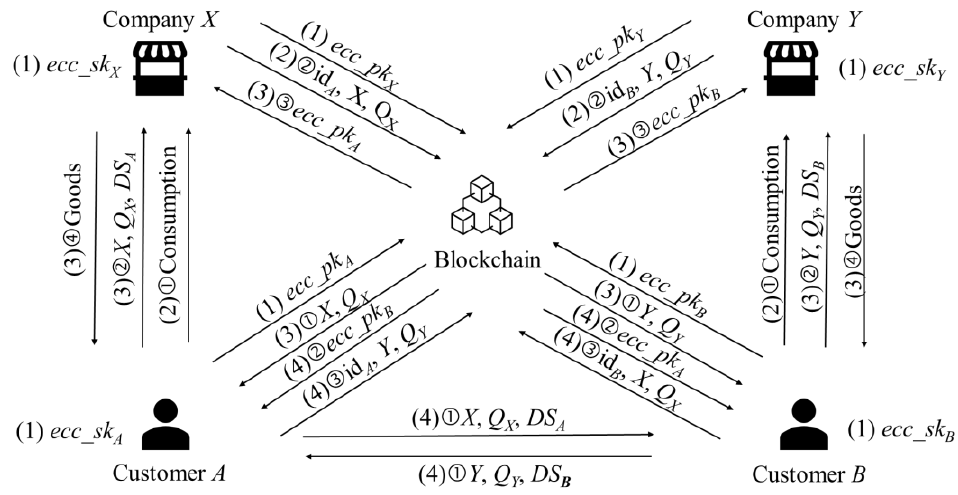
Figure 1. The whole process of the proposed system.